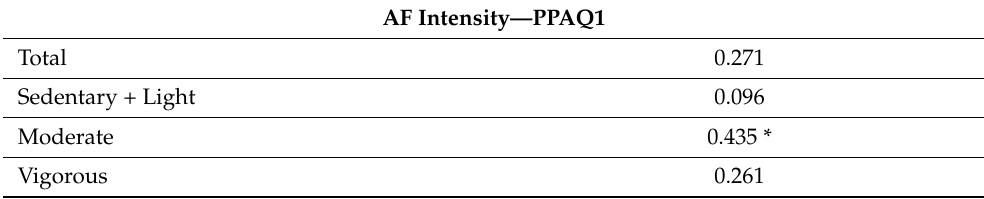
Table 5. Pearson’s correlation between PPAQ and